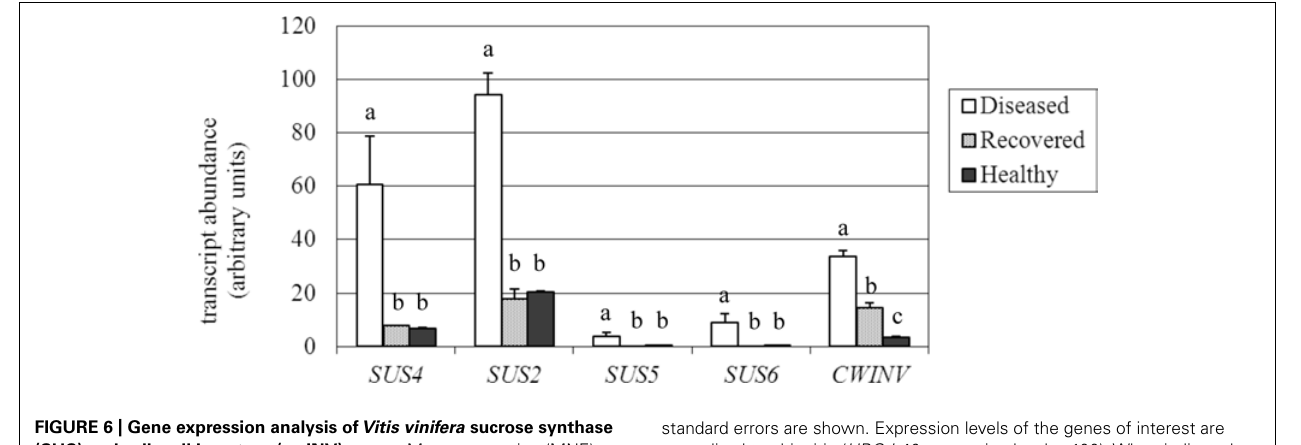
standard errors are shown. Expression levels of the genes of interest are normalized to ubiquitin ( UBQ-L40 expression level = 100).When indicated, different letters denote significant differences ( P <